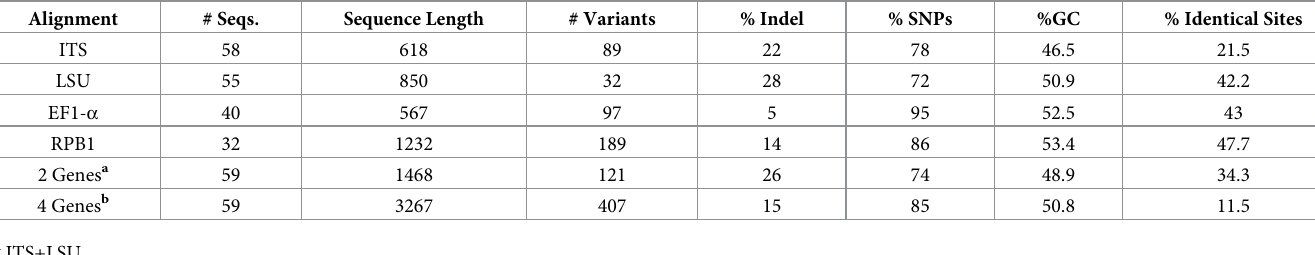
Table 2. Variants’ analysis summary for individual alignments, ITS-LSU, and ITS-LSU-RPB1-EF1- α datasets. Alignment #